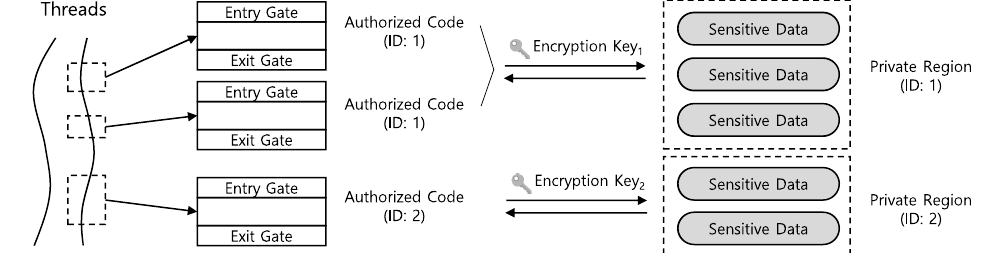
Figure 3. The management scheme for authorized code and private